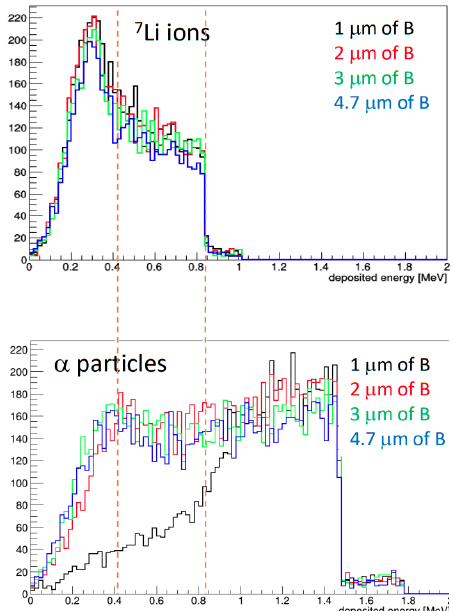
Fig. 2. Energy released for different Boron thickness for 7 Li (top) and α (bottom) in four different simulations of 1M thermal neutrons impinging on the Boron